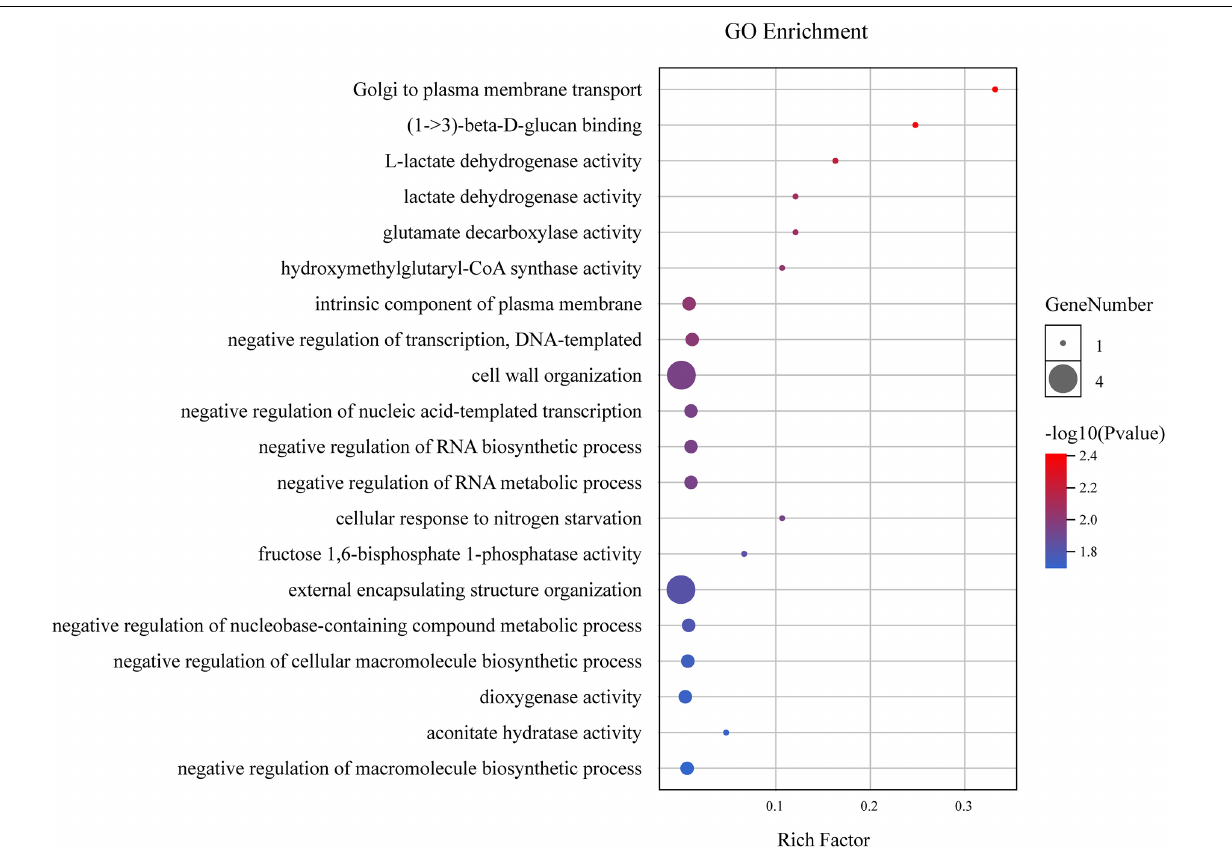
FIGURE 4 | GO analysis of DEGs within the four stable QTL